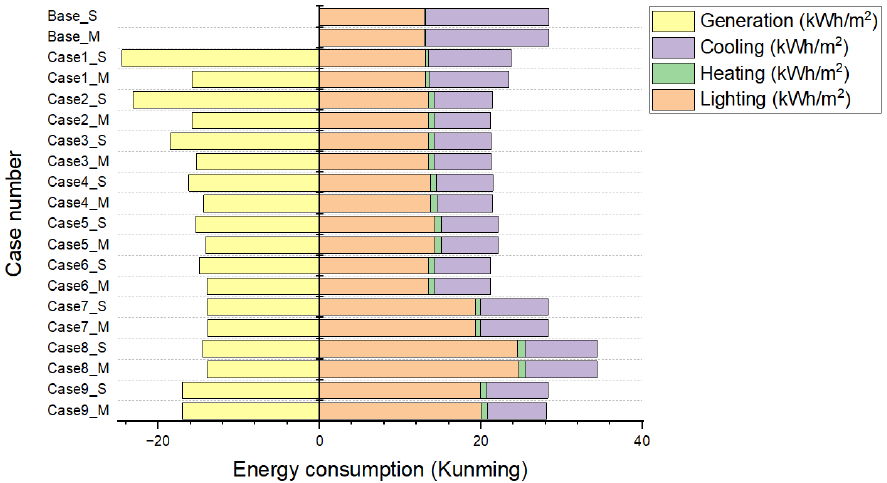
Figure 11. Energy consumption of single-story and multi-story buildings (in Kunming) with differ- ent PVSDs. ent